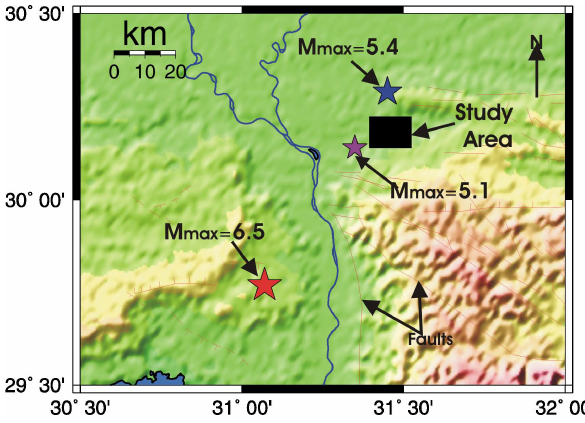
Fig. 8. Location map of M max expected from effective seismogenic zones in and around Greater Cairo